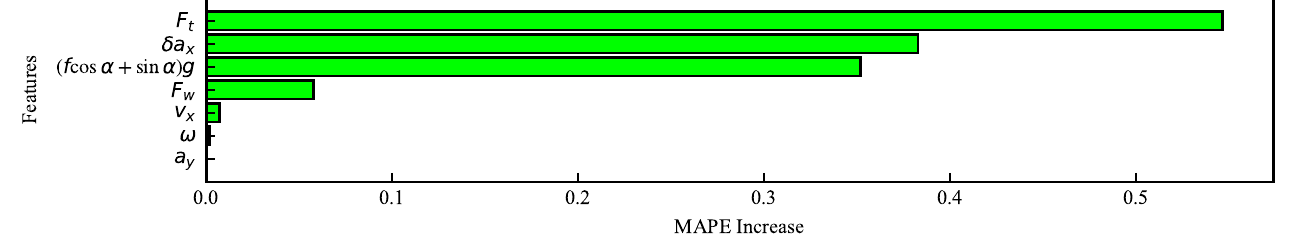
Figure 9. Permutation feature importance shown by MAPE increases when the corresponding feature is removed.